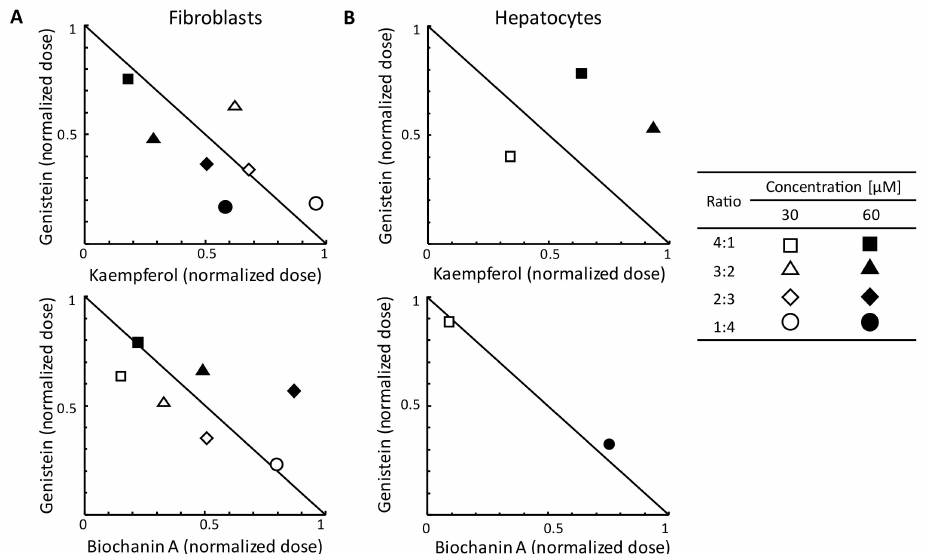
Figure 7. Normalised isobolograms for the non-constant ratio combinations of genistein and biochanin A, and genistein and kaempferol regarding the effect on GAG synthesis inhibition in fibroblasts ( A ) and hepatocytes ( B ). The normalised doses for each component drug were calculated as [D/Dx], where D means the dose of a drug and Dx means the dose of that drug used alone to inhibit the GAG synthesis by x%; this results in values scaled from 0 to 1 for both, x- and y- axes. The solid hypotenuse line denotes the theoretical additive